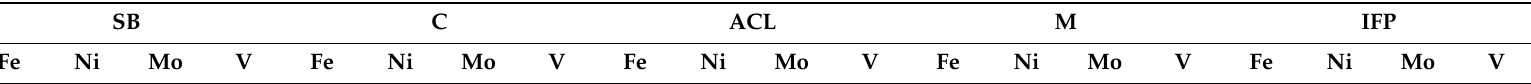
Table 3. Pearson’s correlation between iron, nickel, molybdenum, and vanadium in the analyzed samples (SB, spongy bone; C, cartilage; M, meniscus; ACL, anterior cruciate ligament; IFP, infrapatellar fat pad; NS,